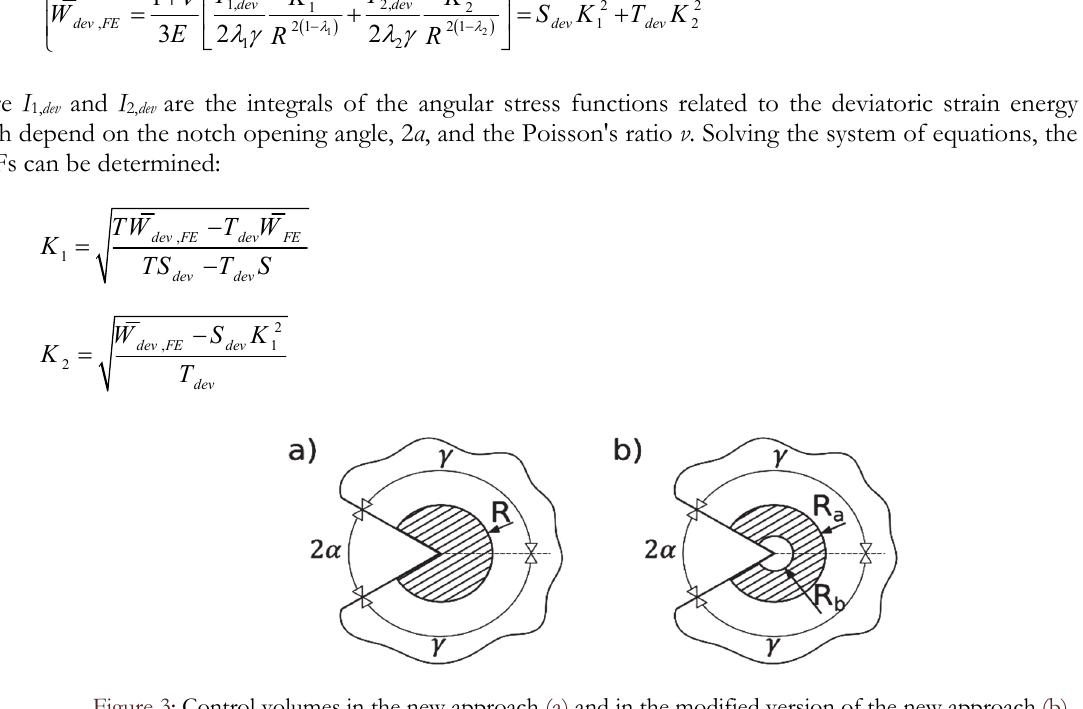
Figure 3: Control volumes in the new approach (a) and in the modified version of the new approach